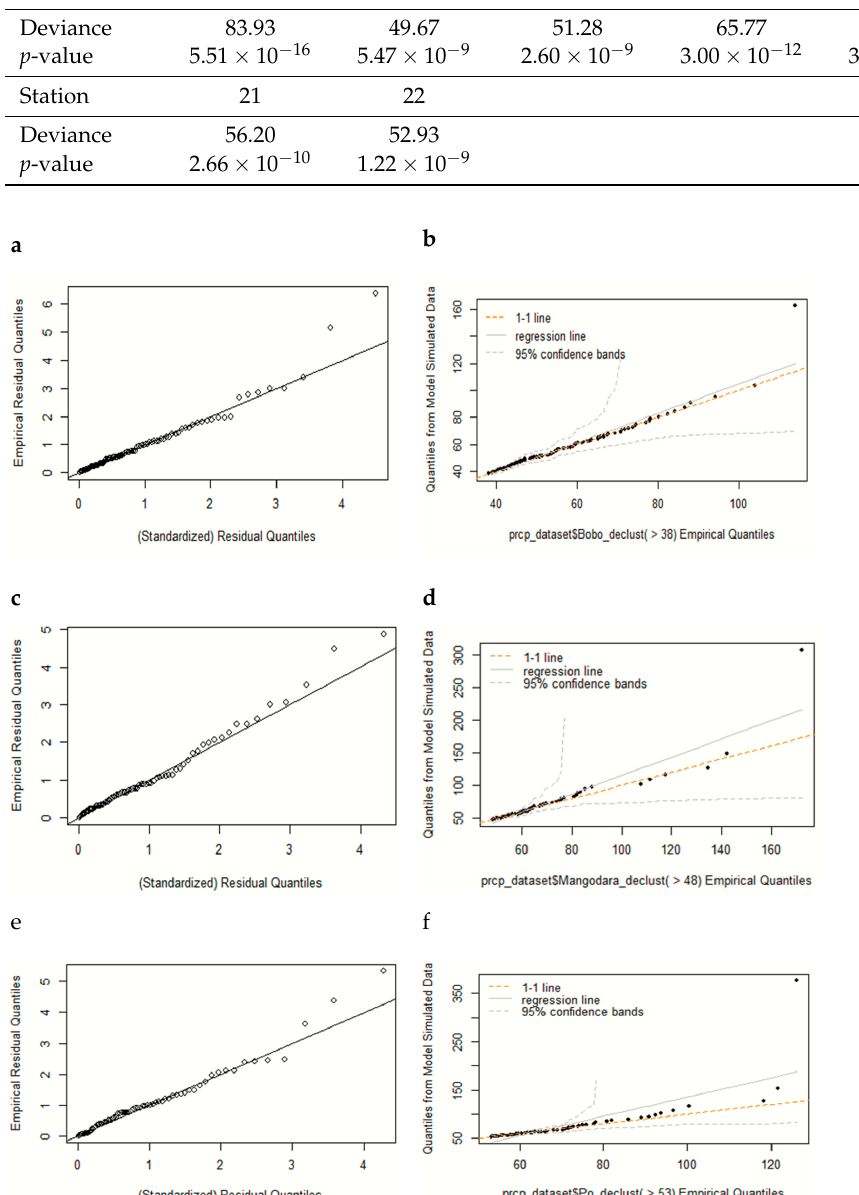
Figure 4. Quantile ( a , c , e ) and probability ( b , d , f ) plots of the nonstationary GP-Poisson model for stations 4, 13 and 18, respectively. These are located in the northwest, southwestern and eastern (see, Figure 1) areas, respectively. The left column denotes the quantile plots ( a , c , e ) of the nonstationary models for station 4, 13 and 18, respectively. The right column represents the probability plots ( b , d , f ) of the same models estimated at stations 4, 13 and 18. The quantile plots ( a , c , e respec- tively) and the probability plots ( b , d , f ) of the nonstationary models for station 4, 13 and 18 respec- tively, are close to unit diagonal which implies that the nonstationary models fit well the data. Figure 5 shows maps of the slope values ( 𝛼 (cid:2869),(cid:3046) ,𝛼 (cid:2870),(cid:3046) ,𝛼 (cid:2871),(cid:3046) ,β (cid:2869),(cid:2929) ,β (cid:2870),(cid:2929) ,𝑎𝑛𝑑 β (cid:2871),(cid:2929) ; Equation (4)) of the nonstationary models. The frequency of extreme rainfall is positively associated with NA SST throughout the study area with comparatively high slope values in the range of 3.1–9.5 (Figure 5a). That means that the frequency of extreme rainfall increases by a factor of 3 to 9 when SST of NA increases by one degree Celsius. The influence of MA and SA SST varies in the study area (Figure 5c,e); extreme rainfall frequency is positively af- fected by higher SST values in some areas, while other areas are negatively affected. The slope values of MA and SA are somewhat lower compared to the slope values slopes of NA. The average of the absolute slopes is 6, 0.6, and 2.6 for NA, MA, and SA, respectively. Hence, changes in SST of NA tend to have a stronger effect compared to changes in SST